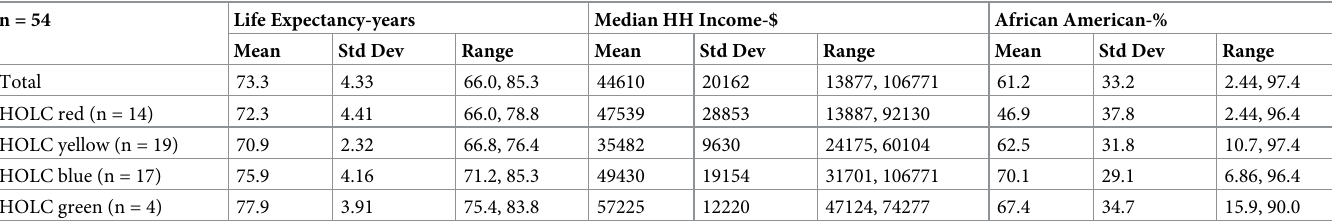
Table 1. Summary statistics for 2013 Baltimore